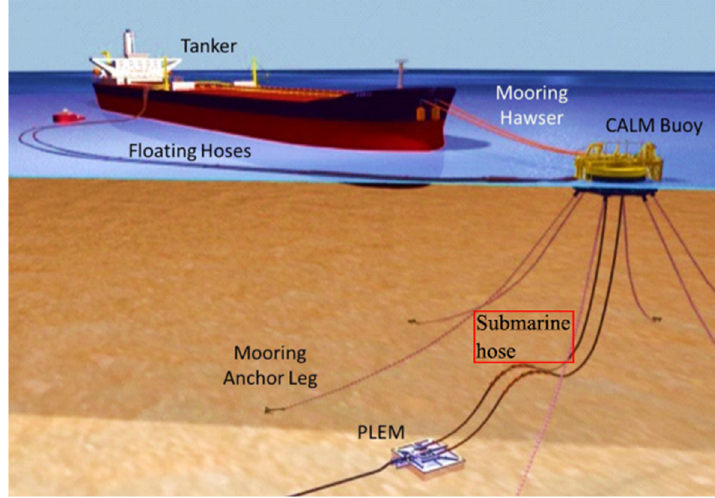
Figure 1. Schematic diagram of single point mooring system.